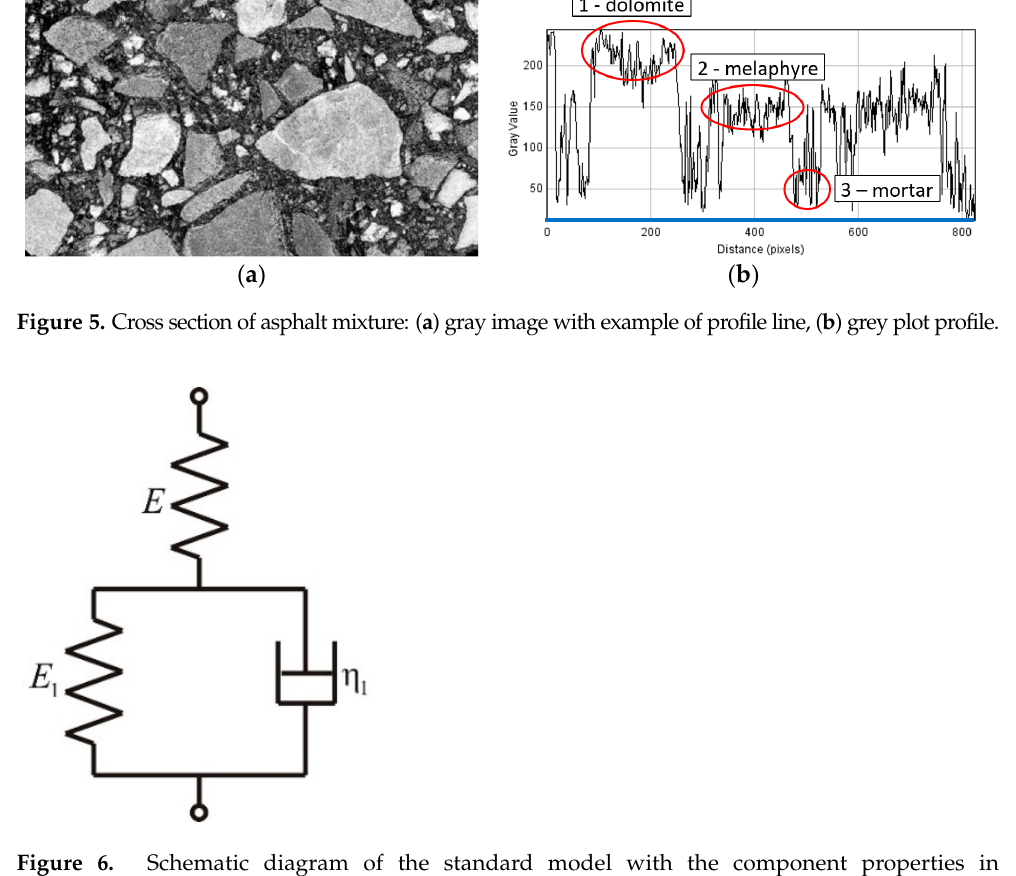
Figure 5. Cross section of asphalt mixture: ( a ) gray image with example of profile line, ( b ) grey plot profile.